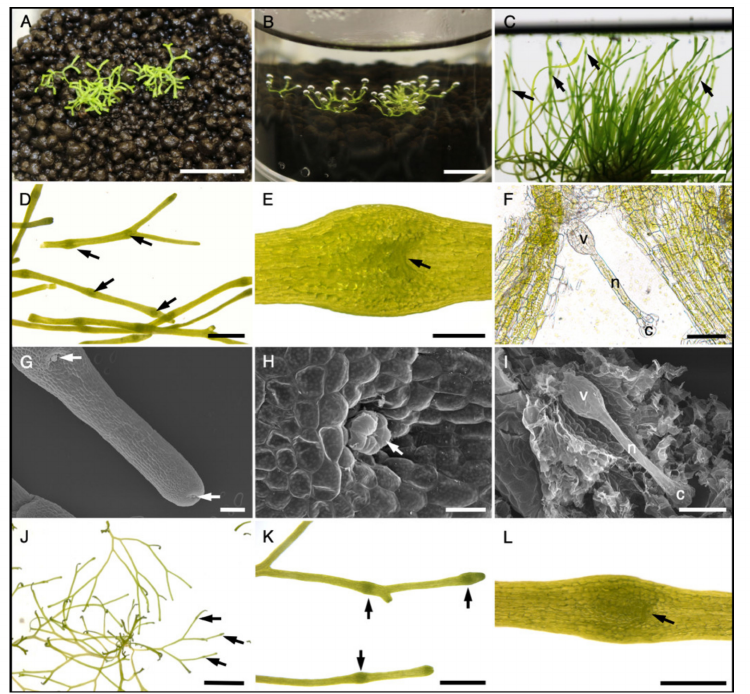
Figure 2. Reproductive tissue induction in R. fluitans 001TC by flooding and starvation. ( A ) Typical LF culture. ( B ) Culture shown in (A) 3 days after flooding with water, when thalli start to grow towards the water surface. ( C ) 14 days after flooding, the induced culture forms multiple archegonium cavities (arrows). ( D ) Close up of thalli with archegonium cavities (arrows). ( E ) Dorsal view of one archegonium cavity with entrance marked by an arrow. ( F ) Squash mount of an archegonium cavity to visualize the archegonium. Venter (v), neck (n), cover cells (c) of the archegonium. ( G – I ) SEM pictures. ( G ) Dorsal side of induced thallus with two archegonium cavities (arrows), the youngest is initiated close to the meristematic zone. ( H ) Archegonium cover cells (arrow) protruding the archegonium cavity. ( I ) Removal of dorsal thallus tissue uncovers the archegonium in the archegonium cavity. ( J – L ) R. fluitans 001TC forms archegonium cavities (arrows) 5 weeks after cultivation on solid 1 / 100 GB5 starvation medium. ( K ) Close up of archegonium cavities (arrows). ( L ) Archegonium cavity with entrance (arrow). Scale bars A,B,C,J: 1 cm; D, K: 2 mm; E,L: 500 µ m; F,I: 100 µ m; G: 200 µ m; H: 50 µ